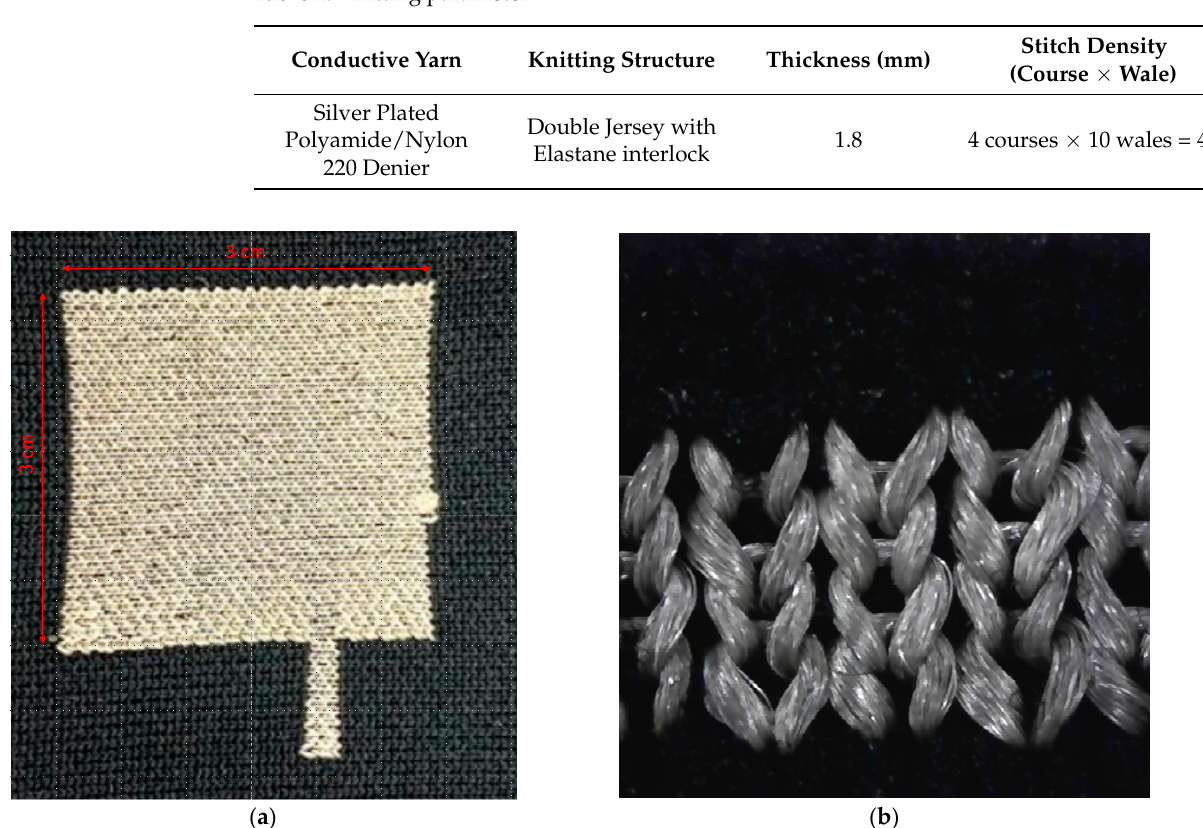
Figure 3. Picture of the knitted sensor ( a ) and knitting pattern ( b